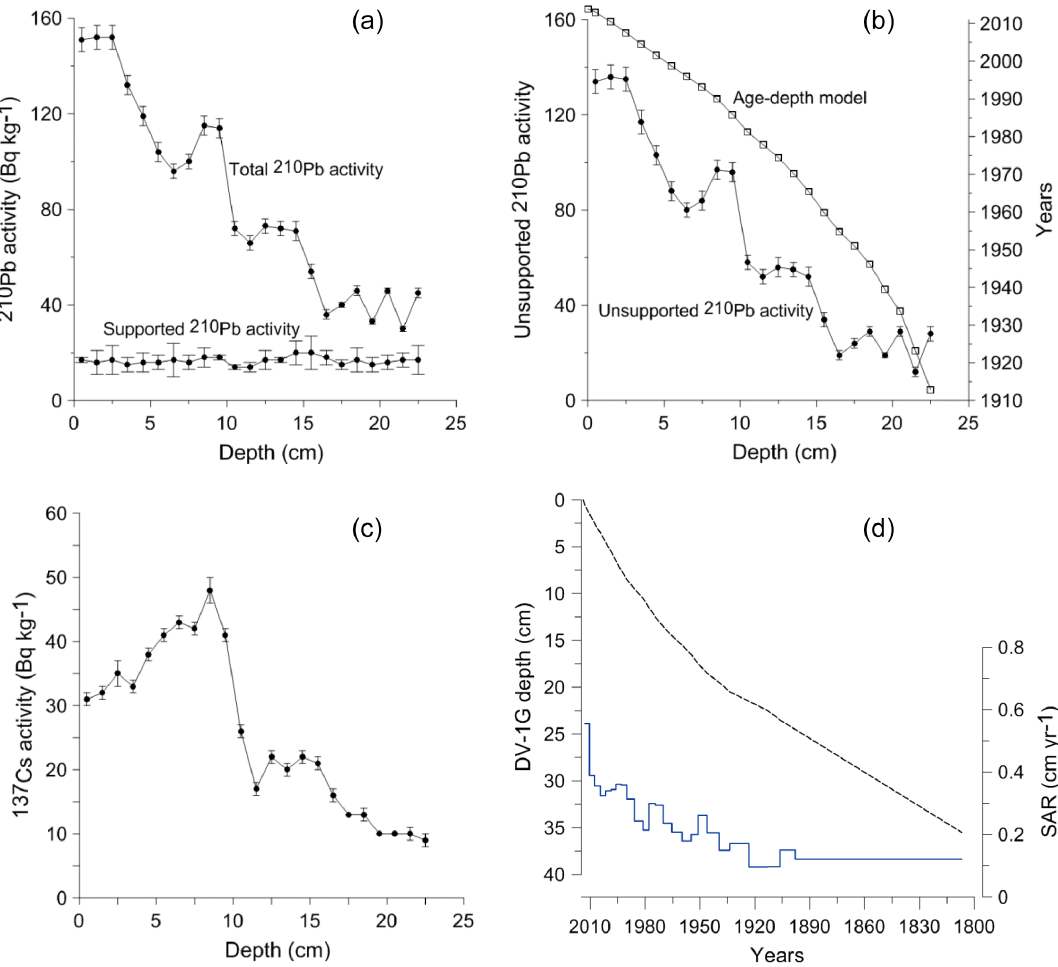
Figure 4. Age–depth calibration for the sediment sequence from the Öresund (DV-1). (a) Total and supported 210 Pb activity. (b) Unsupported 210 Pb activity and the associated age model. (c) 137 Cs activity. The peak corresponds to the Chernobyl reactor accident in 1986. (d) Age– depth model for the whole sediment sequence based on 210 Pb dates and calculated sediment accumulation rates (SARs).